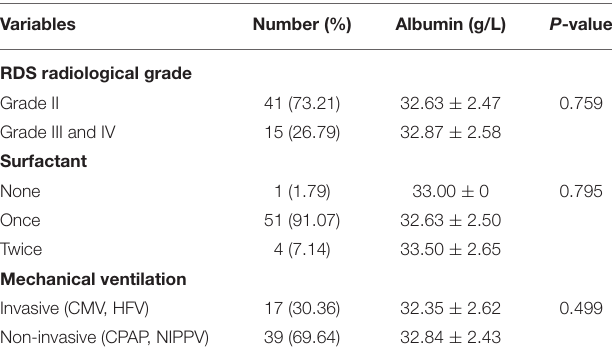
TABLE 6 | Levels of albumin in relation to neonatal clinical characteristics among the RDS group ( n = 56).